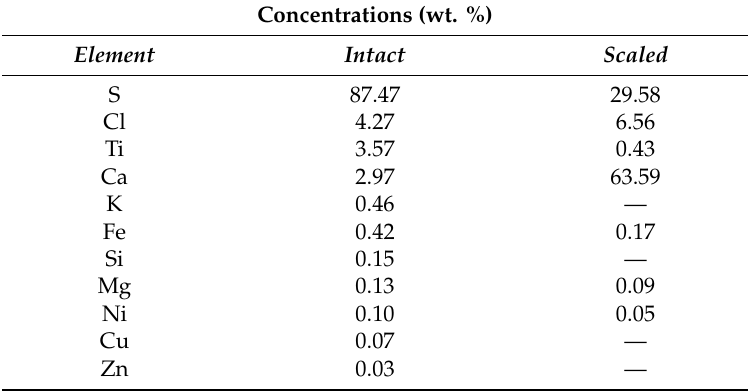
Table 2 lists the elemental compositions of the membrane from XRF analyses. Table 2. XRF analyses of the intact and scaled aquaporin forward osmosis (FO) flat sheet